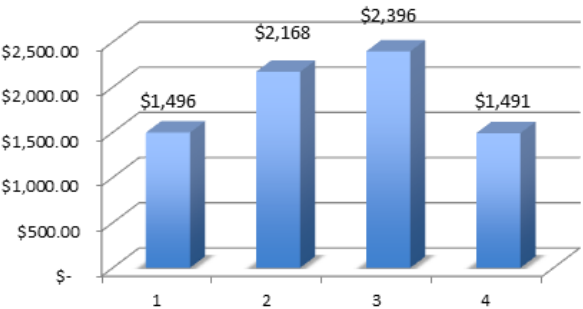
Figure 3. Reduction in Medicare-Allowable